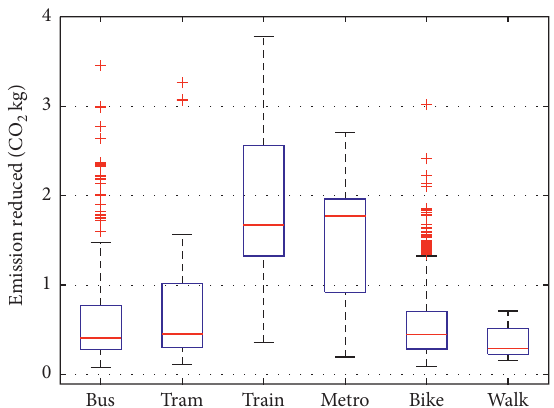
Figure 15: Size range and distribution of potential per-trip emission saving if travelers adopt low-carbon alternative modes. Red marks denote the statistical outliers.